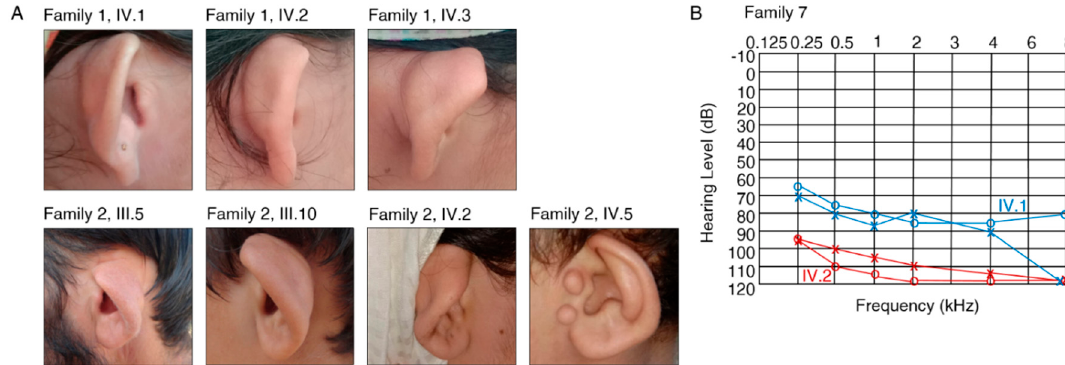
Figure 2. Clinical aspects of patients with previously unreported variants. ( A ) Affected individuals in family 1 (IV.1, IV.2, IV.3) and family 2 (only III.5, III.10, IV.2, IV.5 were available for photographs) show cupped ears and report severe HL. ( B ) Pure-tone audiogram for affected family members IV.1 (blue) and IV.2 (red) in family 7. Left-ear measurements are represented as “x” and right-ear measurements are shown with “o”.